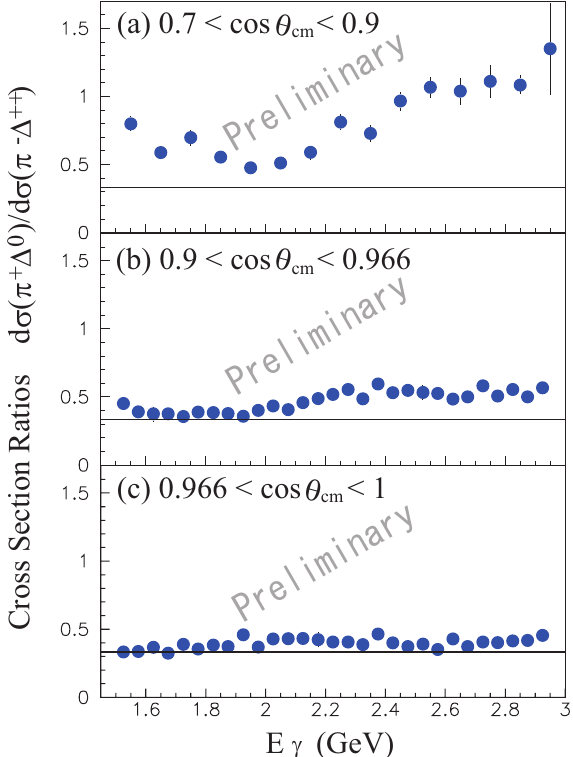
Figure 5. Preliminary cross section ratios d σ ( π + ∆ 0 ) / d σ ( π − ∆ ++ ) for (a) 0.7 < cos θ cm < 0.9, (b) 0.9 < cos θ cm < 0.966, and (c) 0.966 < cos θ cm <